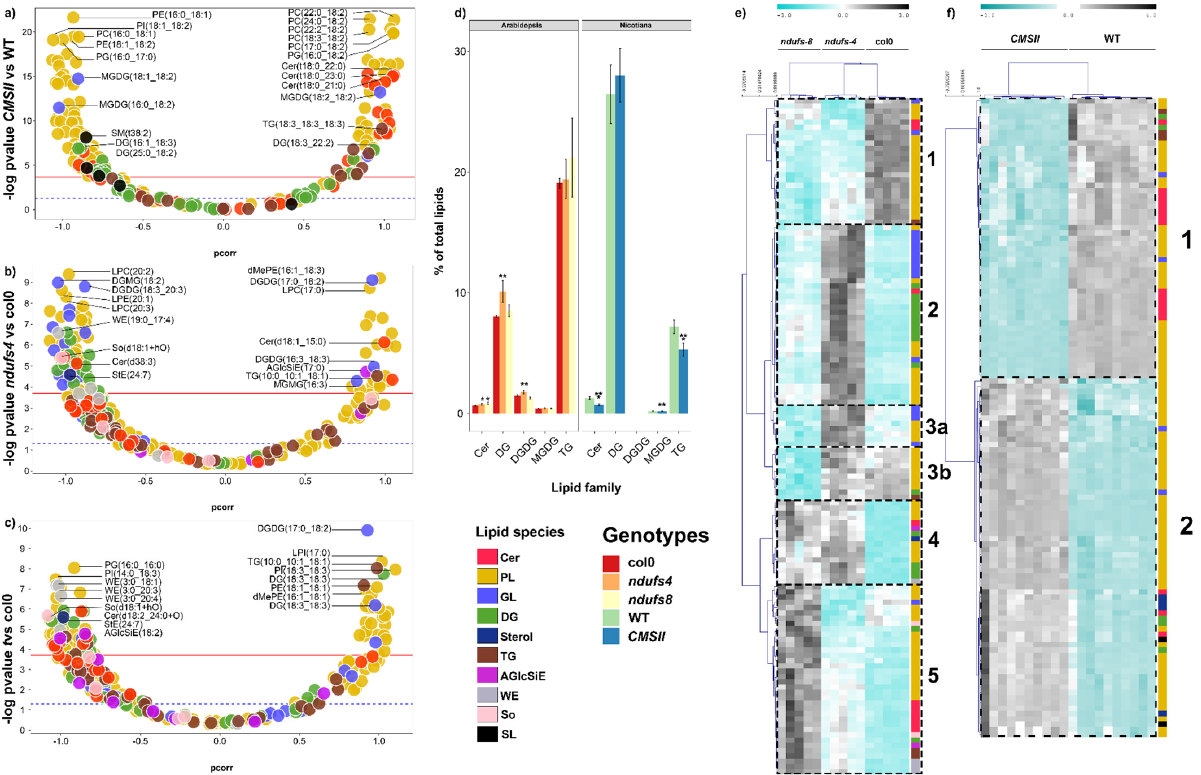
Figure 3. Seed lipidome from LC ‐ MS analysis in wild ‐ type and CI mutants: CMSII (tobacco) and ndufs4 and ndufs8 (Arabidopsis). ( a – c ) Volcano plots showing the weight in sample discrimination (p corr value from OPLS-DA multivariate analysis) against the p -value (Welch t-test, univariate anal- ysis) to show the best lipid biomarkers between mutants (on the left) and wild ‐ type (on the right). ( d ) Relative LC ‐ MS signal of whole lipid families in the percentage of total lipid signal. ( e – f ) Heat map and hierarchical clustering (left) showing lipids that differed significantly ( p < 0.05 with Bonferroni correction, two-way ANOVA) between genotypes. The colour scale stands for relative metabolite content from low (cyan) to high (grey, colour scale on top). The colour legend at the bottom of this figure indicates lipid species families presented in ( a – c ) and genotypes in ( d ). A